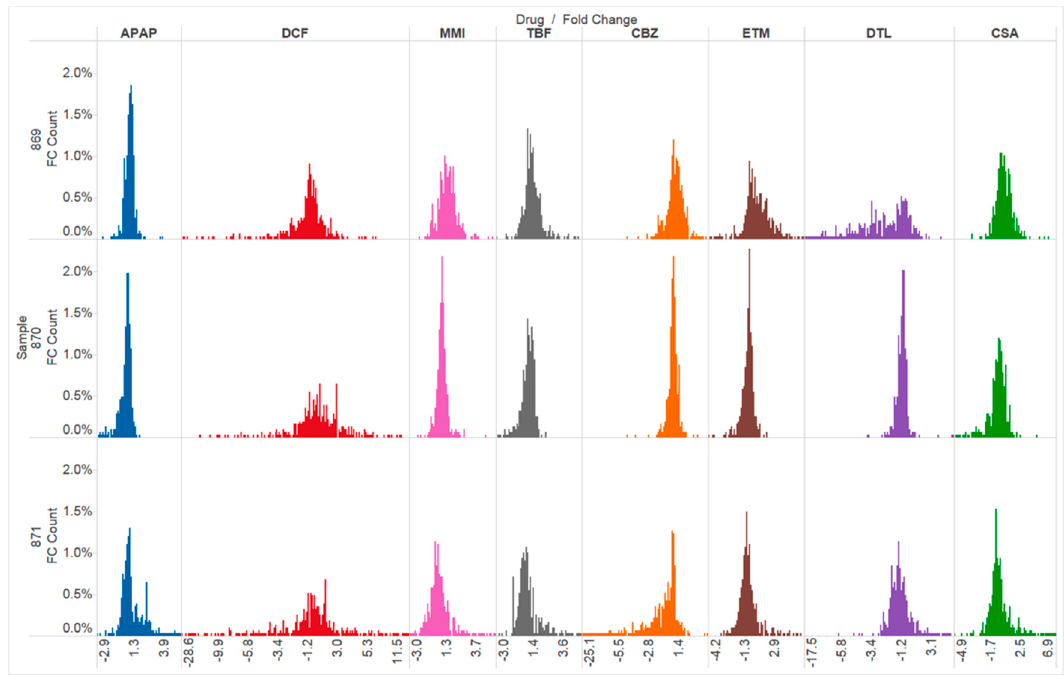
Figure 3. Histograms of fold change and distribution of the 370 genes queried with the human specific Molecular Toxicology Pathway Finder PCR array. Each column corresponds to a drug and each row corresponds to the individual human livers (869, 870, 871). The global response to the drugs has the same distribution across the drugs, except for DCF and DTL in human liver 869 in which a greater number of genes were altered.